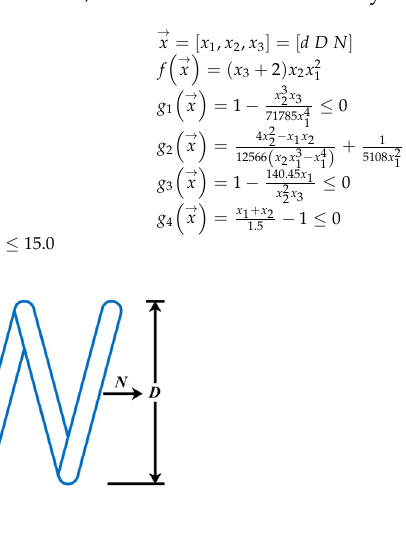
Figure 9. Design of a tension/compression spring problem.